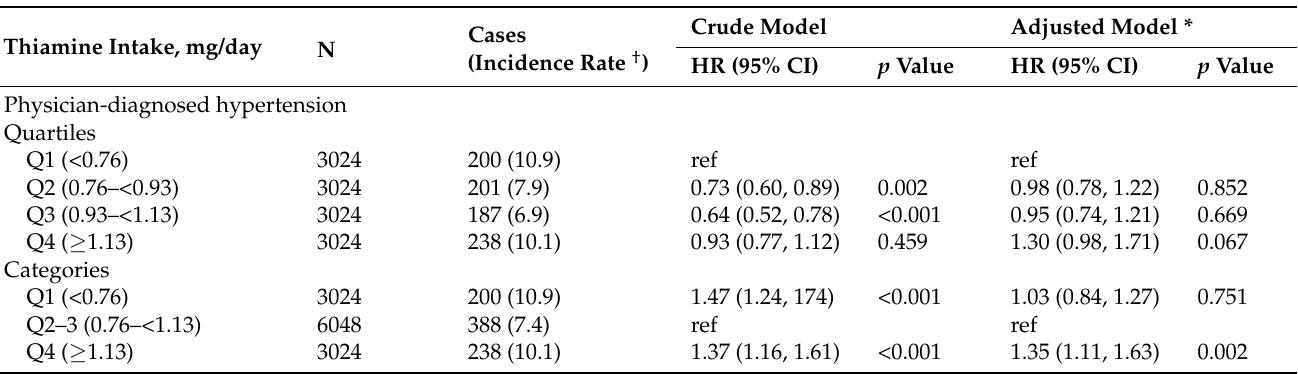
Table 4. Association between dietary thiamine intake and risks of different components of new-onset